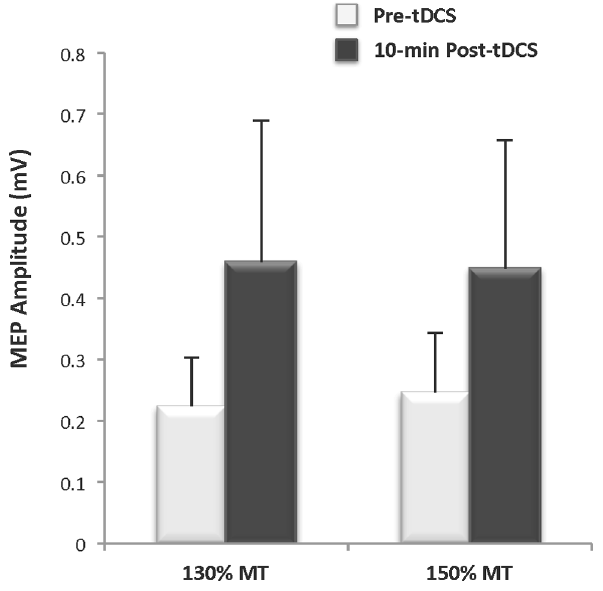
Figure 3. Pilot study: after-stimulation effects of anodal tDCS on cortical excitability (n=4). Motor evoked potential (MEP) amplitude measured in the biceps 10 minutes after anodal transcranial direct current stimulation (tDCS: 1.0 mA, 35 cm 2 , 20 minutes) increased by 105% and 82% relative to pre-stimulation baseline at transcranial magnetic stimulation (TMS) intensities of 130% of motor threshold (MT) and 150% of MT, respectively (ES=0.24).